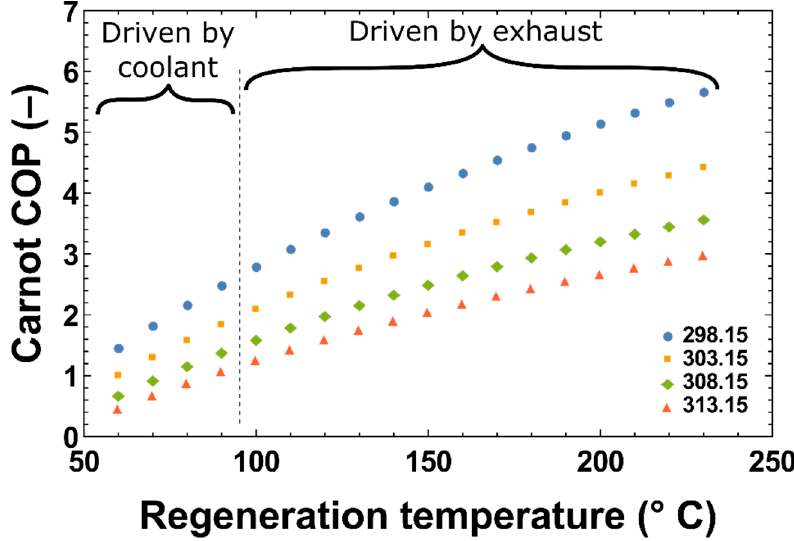
Figure 3. The Carnot coefficient of performance ( COP ) of the adsorption cycle at various heat source and coolant temperatures.